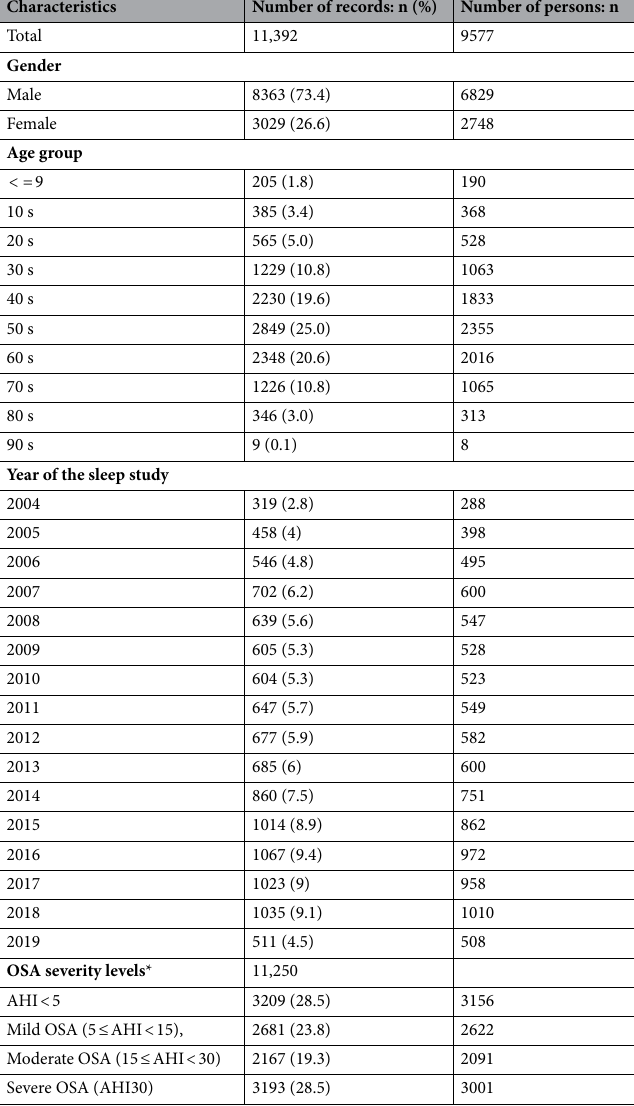
Table 2. Demographic characteristics of total sleep tests that were converted into OMOP CDM. The sleep tests from February 2004 to June 2019 were extracted, transformed, and loaded into the OMOP CDM. *The prevalence of OSA severity levels were calculated based on Apnea Hypopnea Index (AHI) for only records with AHI